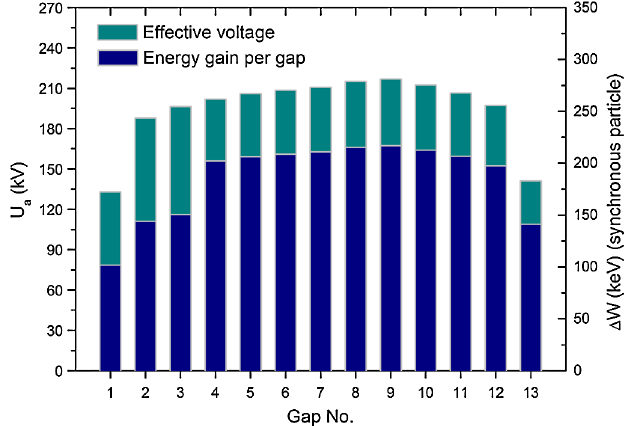
FIG. 15. (Color) Effective voltage on beam axis and related energy gain per gap for a synchronous particle of the first CH cavity.